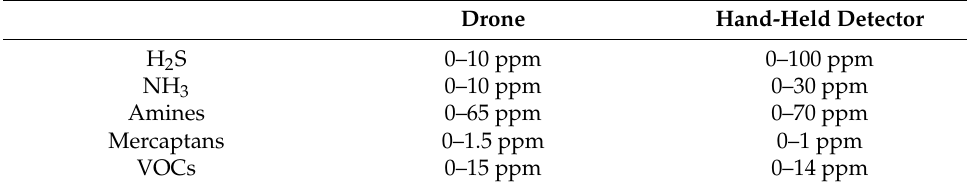
Table 3. Comparison between drone-based measurements and those performed with a hand-held X-am 8000 detector near the same emission